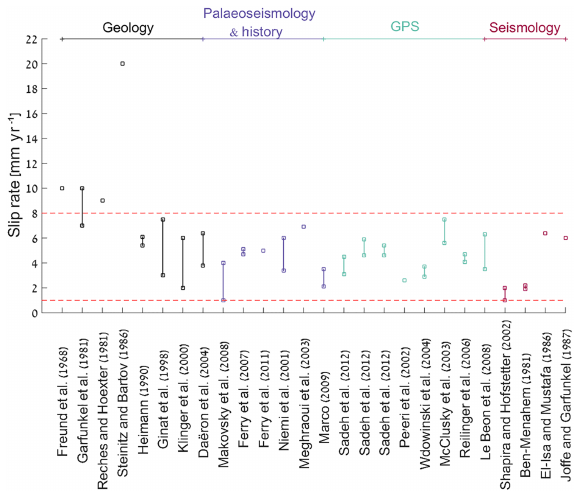
Figure 5. Summary of the different slip-rate estimates, based on previous studies from a range of disciplines and representing differ- ent time windows.